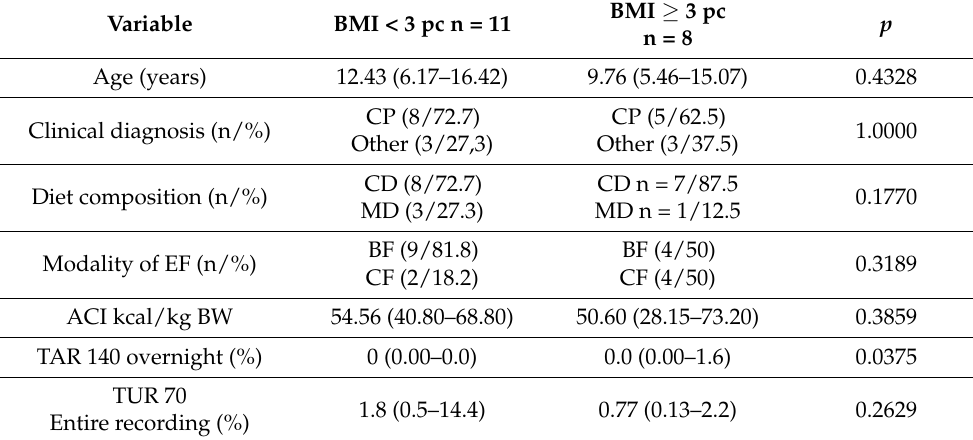
Table 5. Characteristics of patients in study with reference to BMI-pc (n =